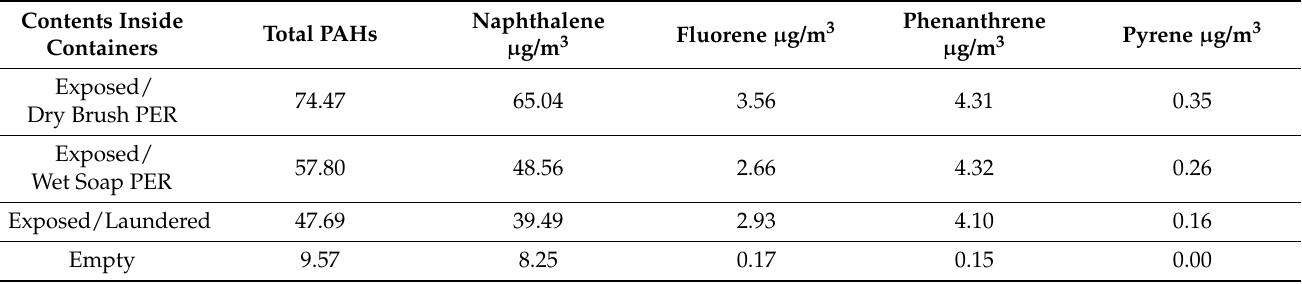
Table 2. Off-gas PAH concentrations ( µ g/m 3 ) for the four most dominant analytes (Fluorene, Naph- thalene, Phenanthrene, and Pyrene) measured from containers (N = 1 type of gear or no gear per container) over 24